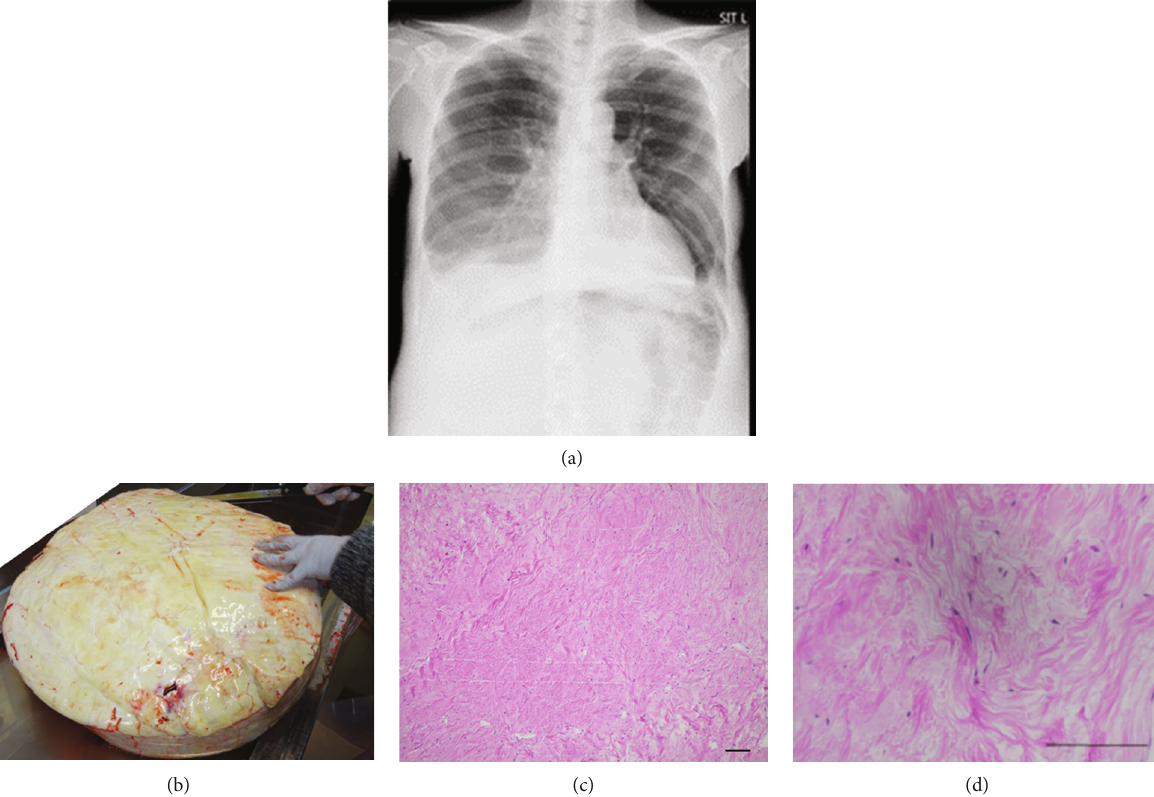
Figure 3: Postoperative fi ndings and pathological fi ndings. (a) Chest X-ray on the fourth postoperative day showed marked decrease of pleural e ff usion. (b) Macroscopic fi nding of the tumor. It was nearly white, and there were no obvious necrotic lesions. (c, d) Microscopic fi ndings. The tumor was composed of thin spindle cells in a whorled arrangement, and nuclear atypia and mitosis were not observed. (c) × 40 magni fi cation: black bar is 1mm. (d) × 100 magni fi cation: black bar is 200 μ